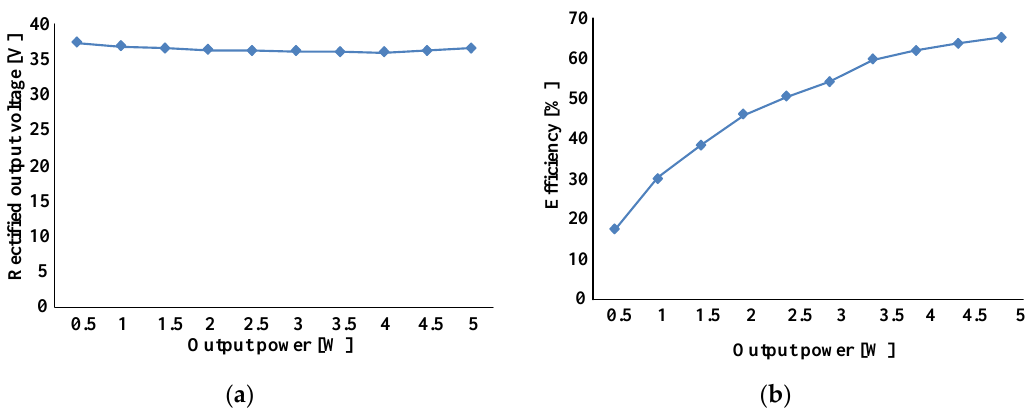
Figure 13. Output voltage and efficiency according to load variation: ( a ) output voltage; ( b ) efficiency.